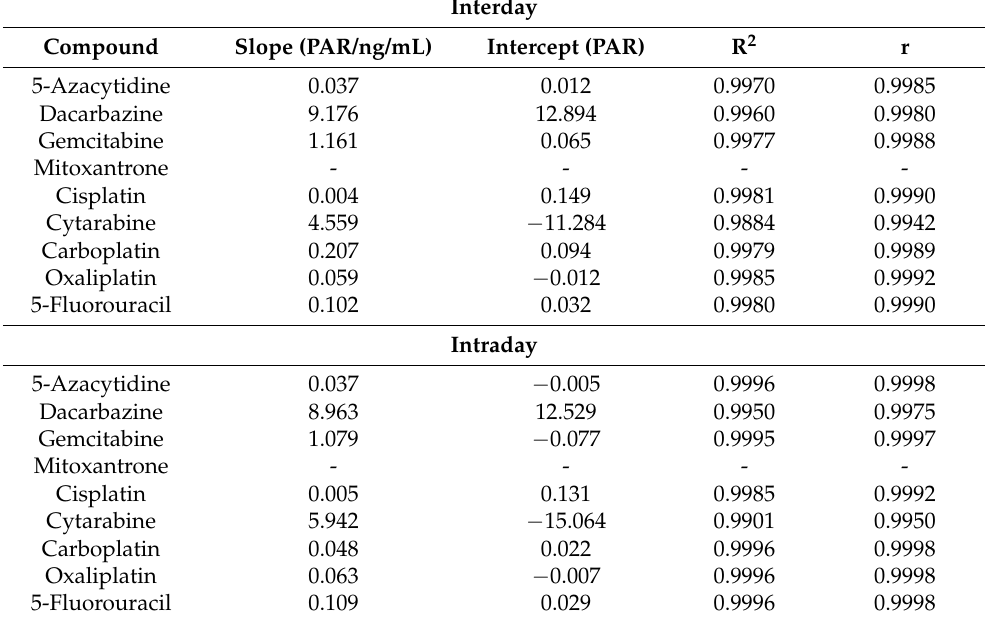
Table 3. Linear regressions data obtained for each analyte.